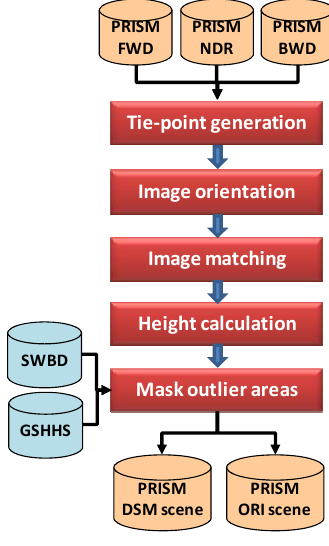
Figure 1. Processing flow of PRISM/DSM scene data